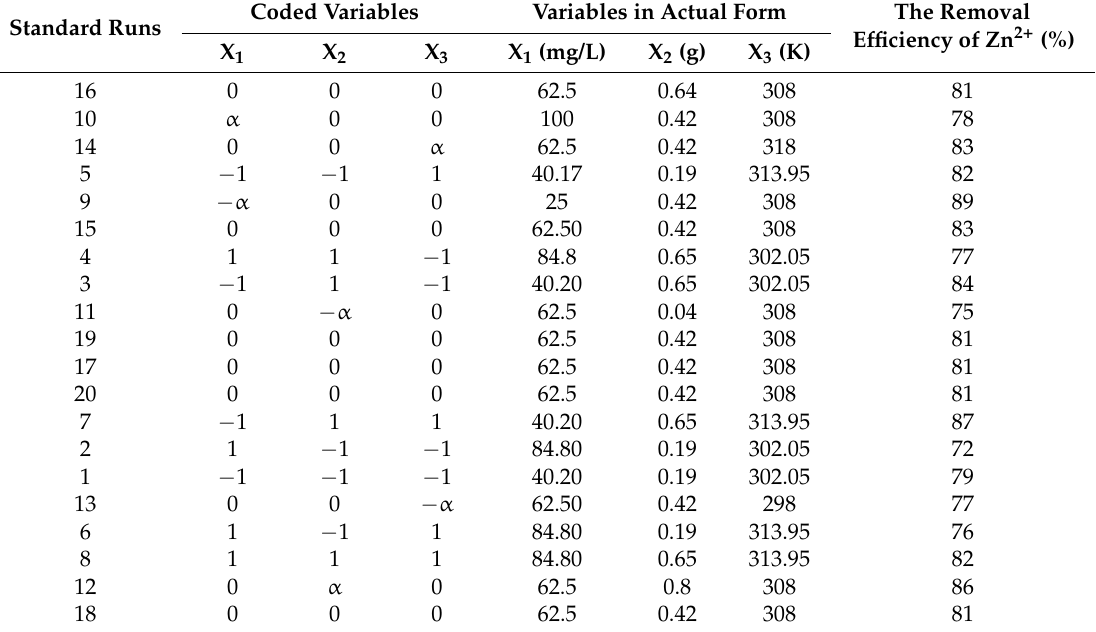
Table 1. Detail Experimental runs for central composite design with factor values in the coded form and respective responses/output.